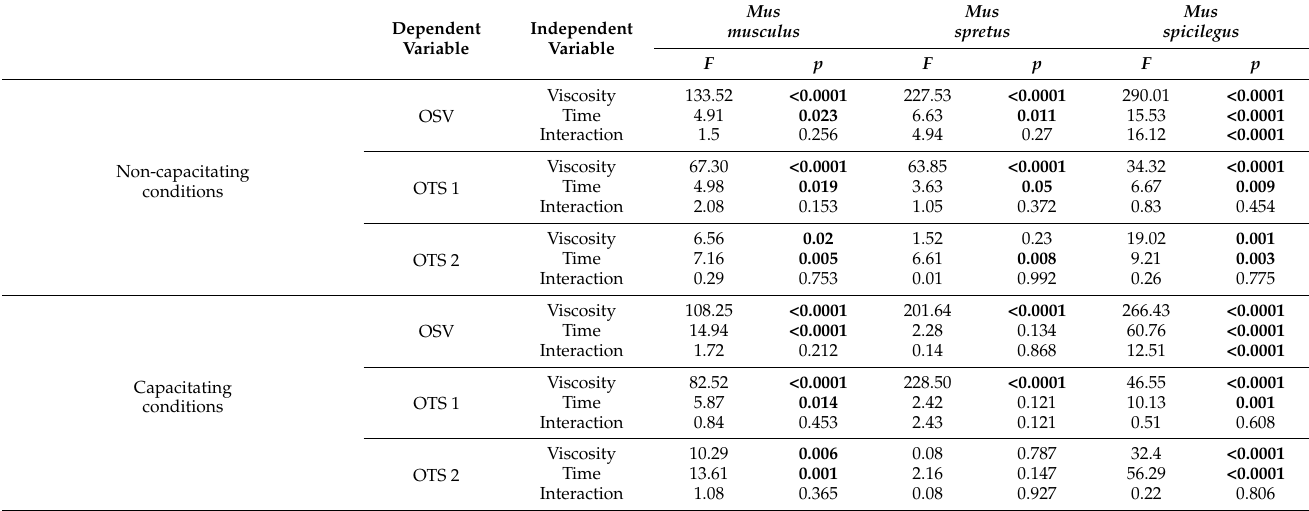
Table 5. Effect of time and incubation in two non-capacitating treatments (low and high viscosity) and two capacitating conditions (low and high viscosity) on overall sperm velocity (OSV) and overall trajectory shape (OTS 1 and OTS 2). Values of F and p are the result of repeated measures analyses (ANOVAs). Incubation conditions and time of incubation were defined as fixed factors, and the individual was defined as a random factor. Results highlighted in bold show significant differences in statistical analysis ( p <